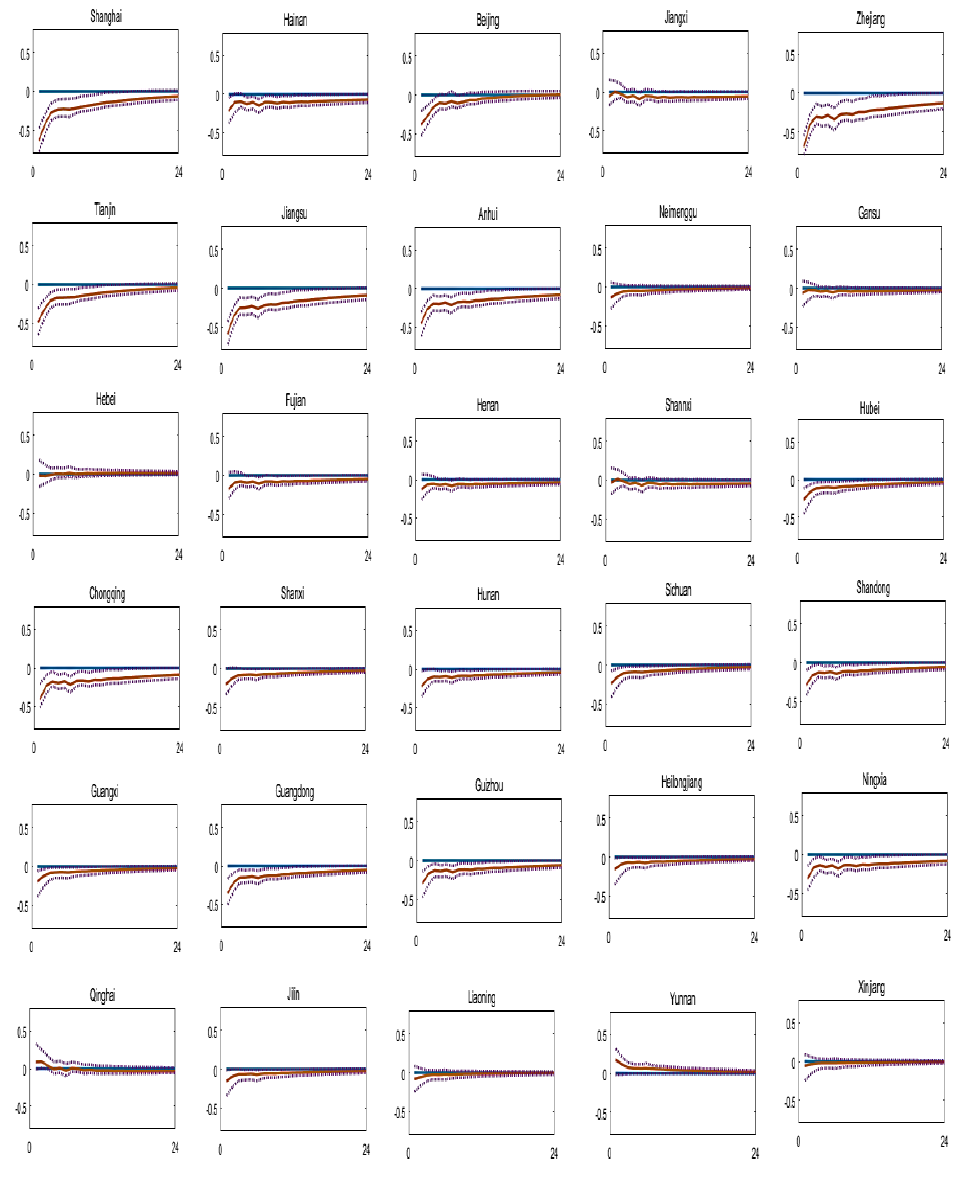
Figure 2. Impulse responses of regional house prices to one standard error shock to the interest rate: FAVAR system with one factor.